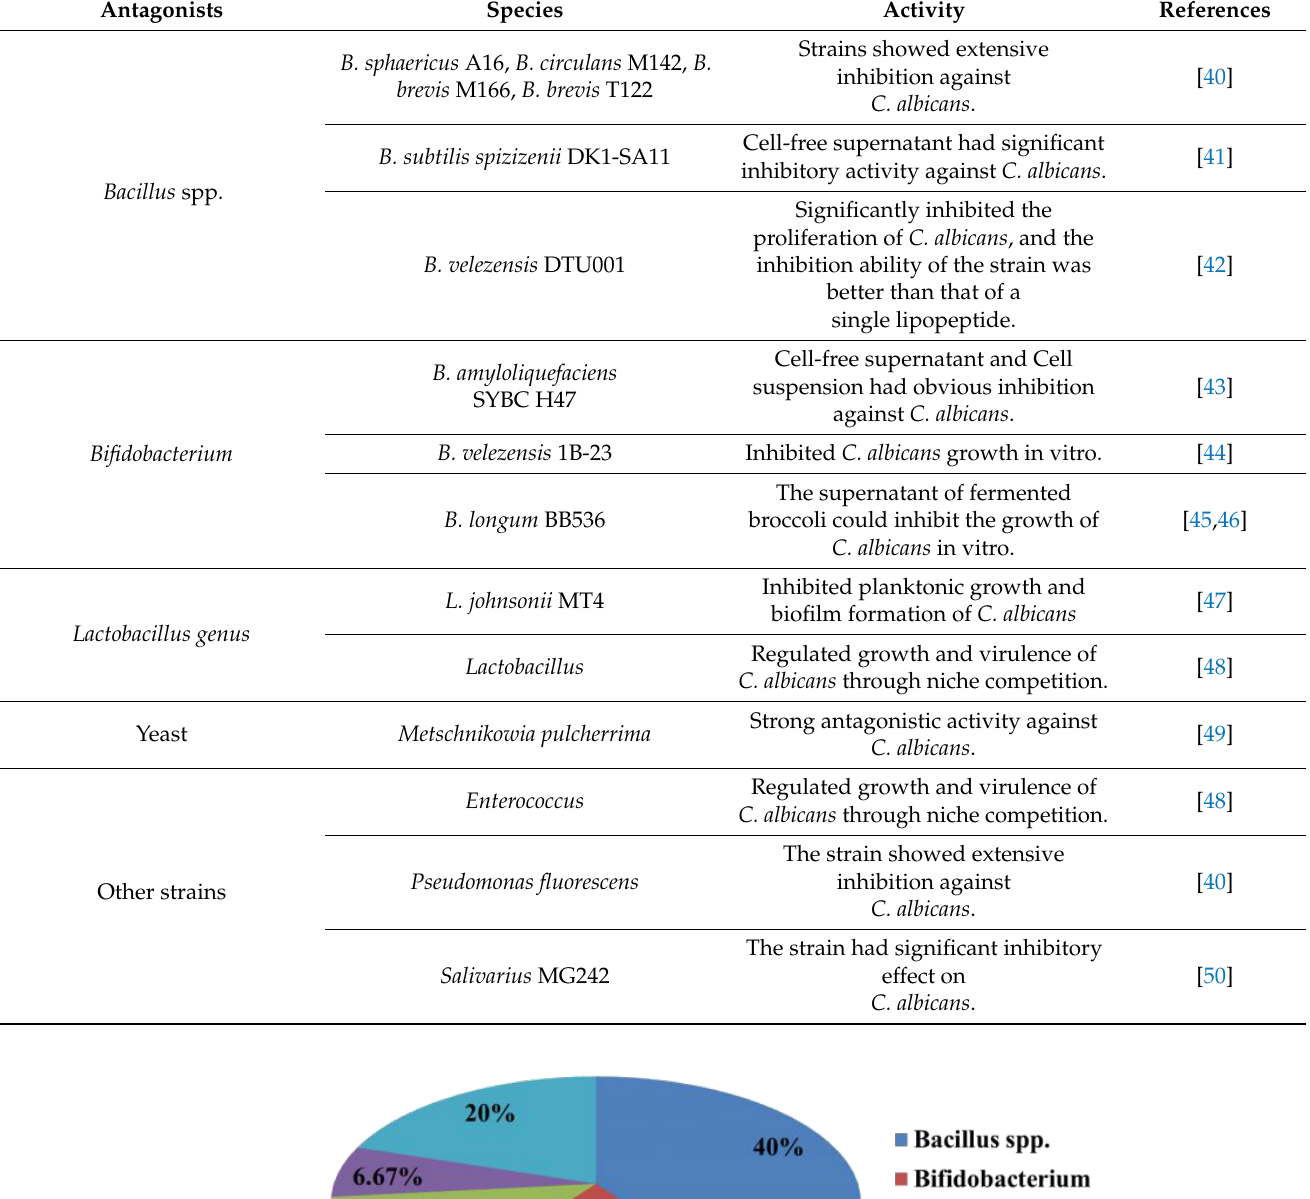
Table 1. Antagonistic Microbes against C. albicans .